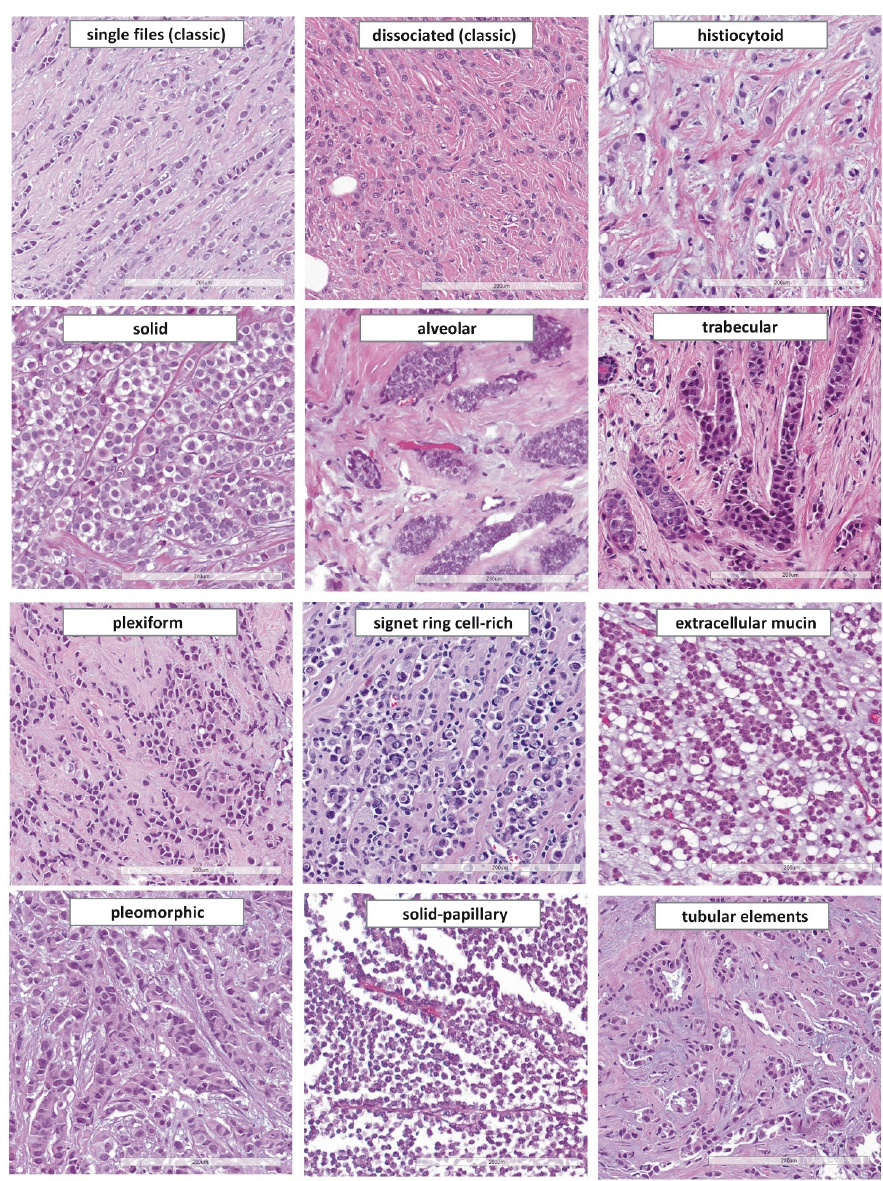
Figure 4. Histomorphology of ILC variants reported in the scientific literature. From top left to lower right: single file growth pattern (classical ILC), dissociated growth pattern (classical ILC), histiocytoid ILC, solid ILC, alveolar growth pattern, trabecular growth pattern, plexiform growth pattern, signet ring cell-rich ILC, ILC with extracellular mucin, pleomorphic ILC, solid-papillary ILC, ILC with tubular elements (×200 magnification).